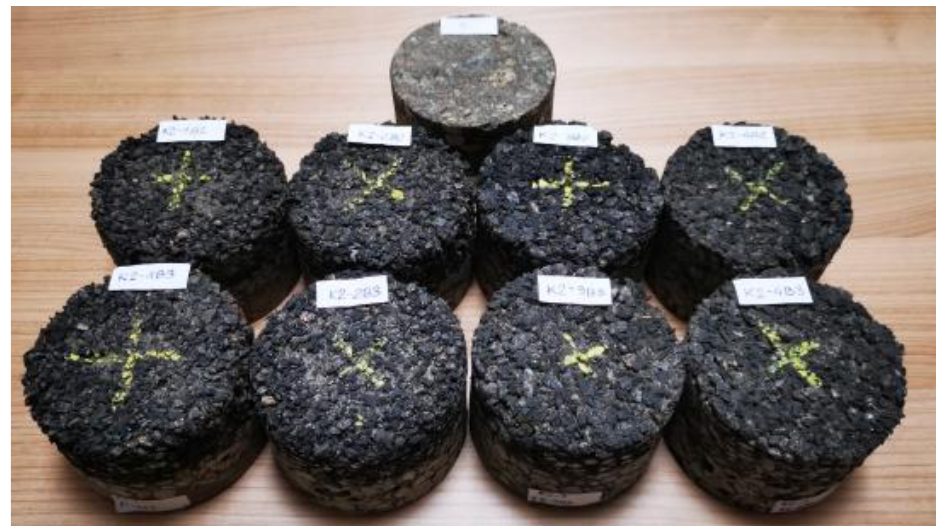
Figure 6. Specimens taken from pavements made to standardized dimensions.